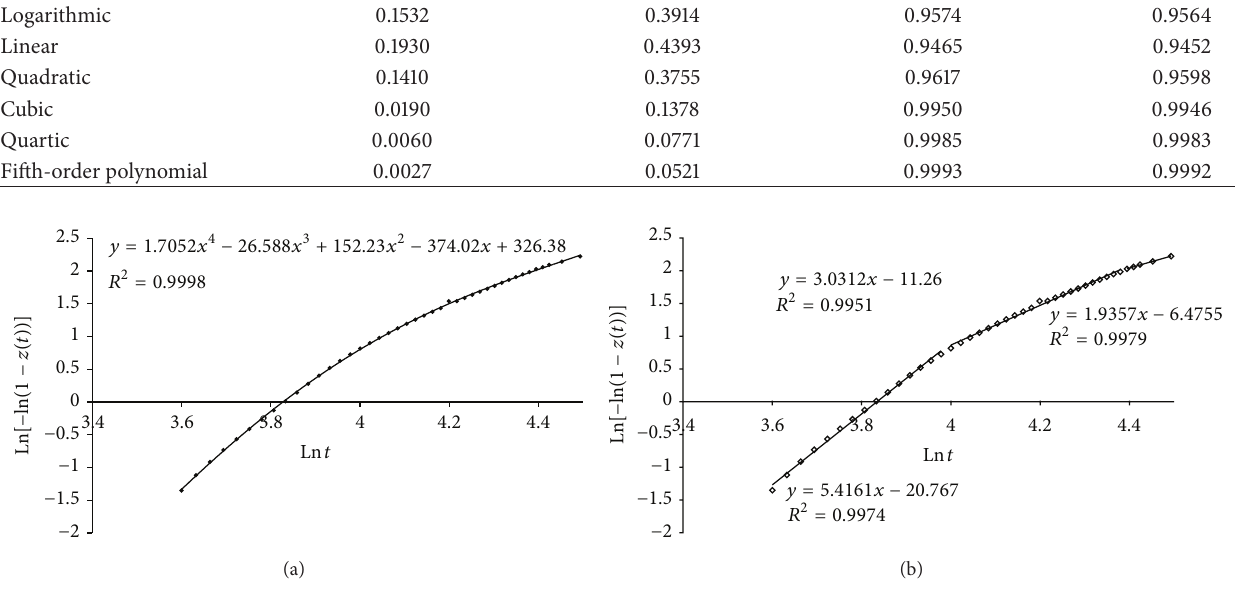
Figure 4: Plot of ln [− ln ( 1 − 𝑧(𝑡))] against ln 𝑡 for In isothermally crystallized at 156 ∘ C. (a) Polynomial regression. (b) Linear interpolations in limited ranges of ln 𝑡